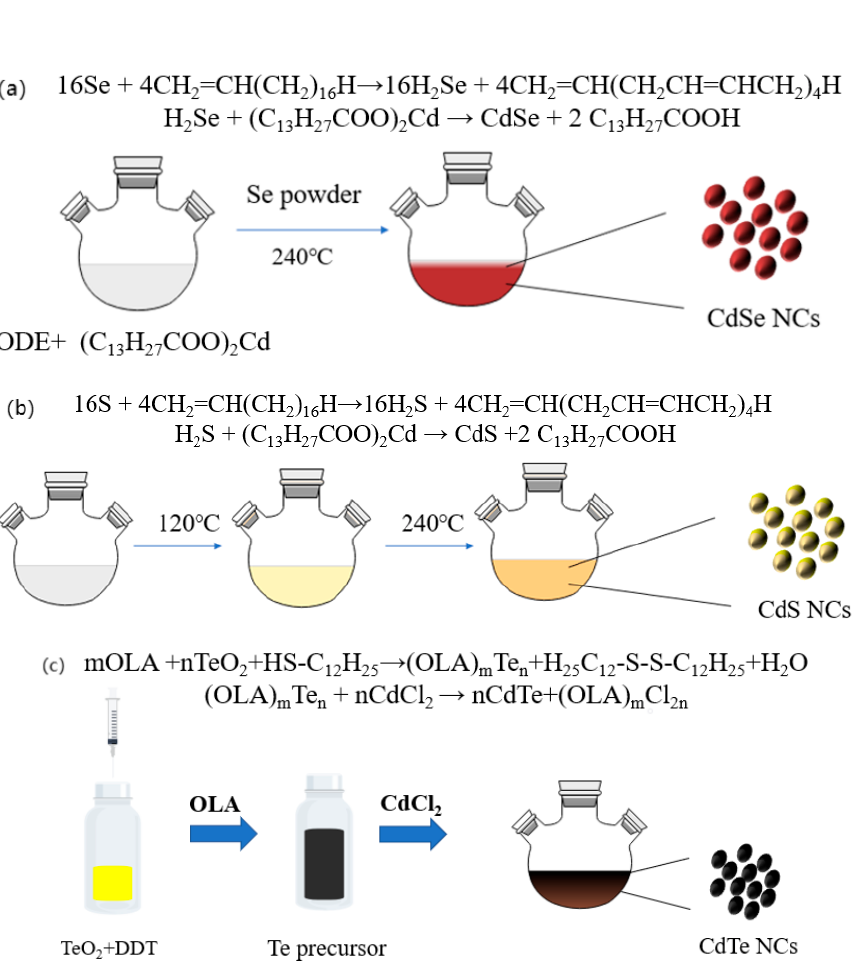
Figure 1. A schematic diagram of the NC fabricating process ( a ) CdSe, ( b ) CdS, ( c ) CdTe NCs.